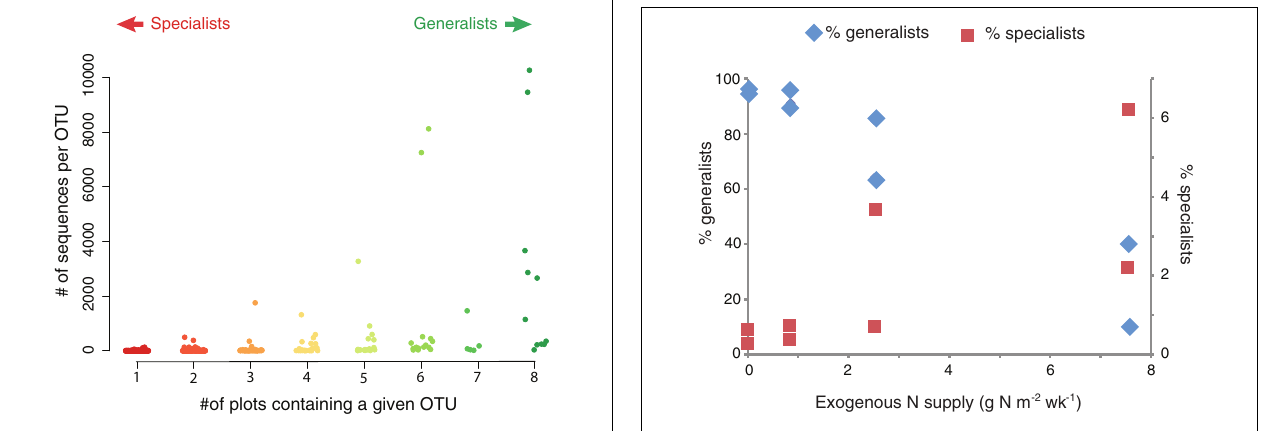
FIGURE 5 | Relationship between exogenous nitrogen supply and the proportion of generalists (left axis) and specialists (right axis). The two symbols per nitrogen supply represent values for the two duplicated plots per